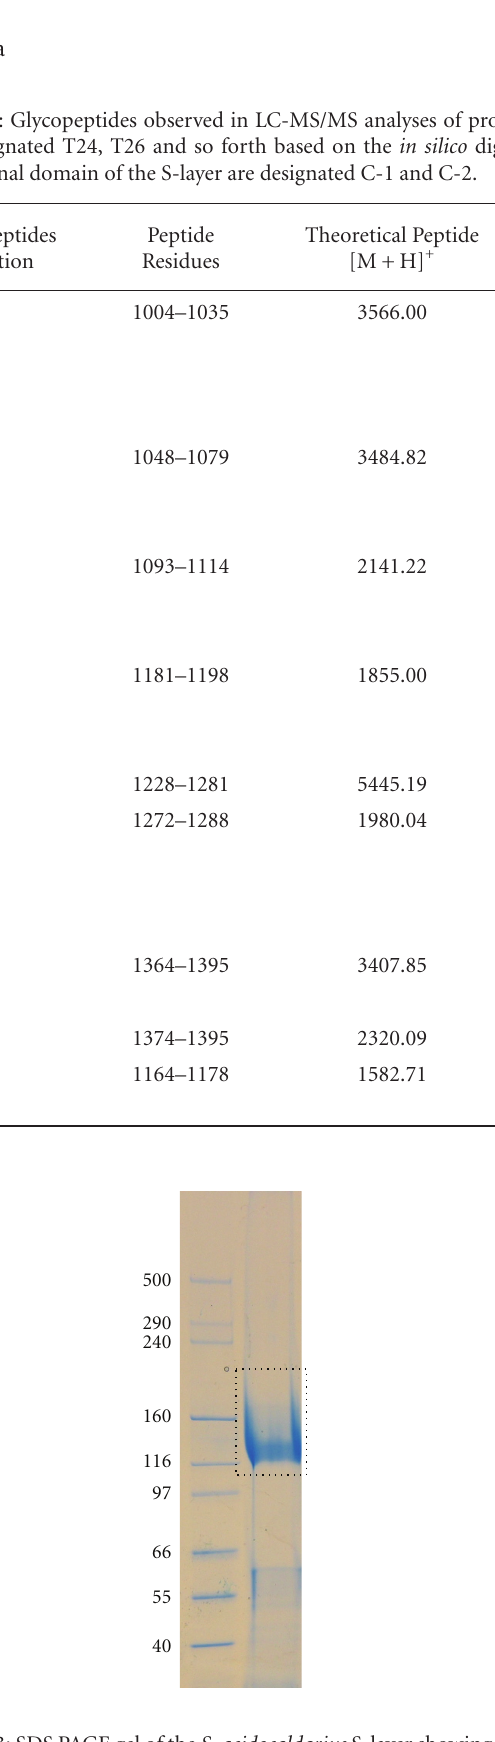
Figure 3: SDS PAGE gel of the S. acidocaldarius S-layer showing the band that was cut out for in-gel